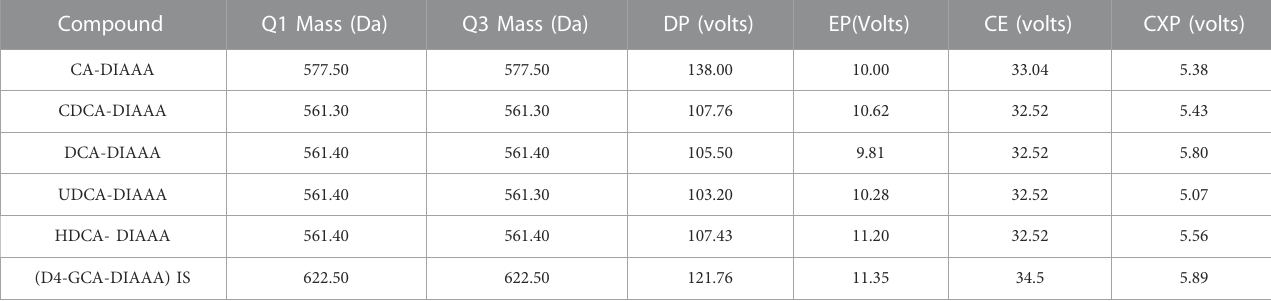
TABLE 2 Mass spectrometric characteristics of CA-DIAAA, CDCA-DIAAA, DCA-DIAAA, UDCA-DIAAA, HDCA-DIAAA, and IS-DIAAA (D4-GCA-DIAAA). Compound